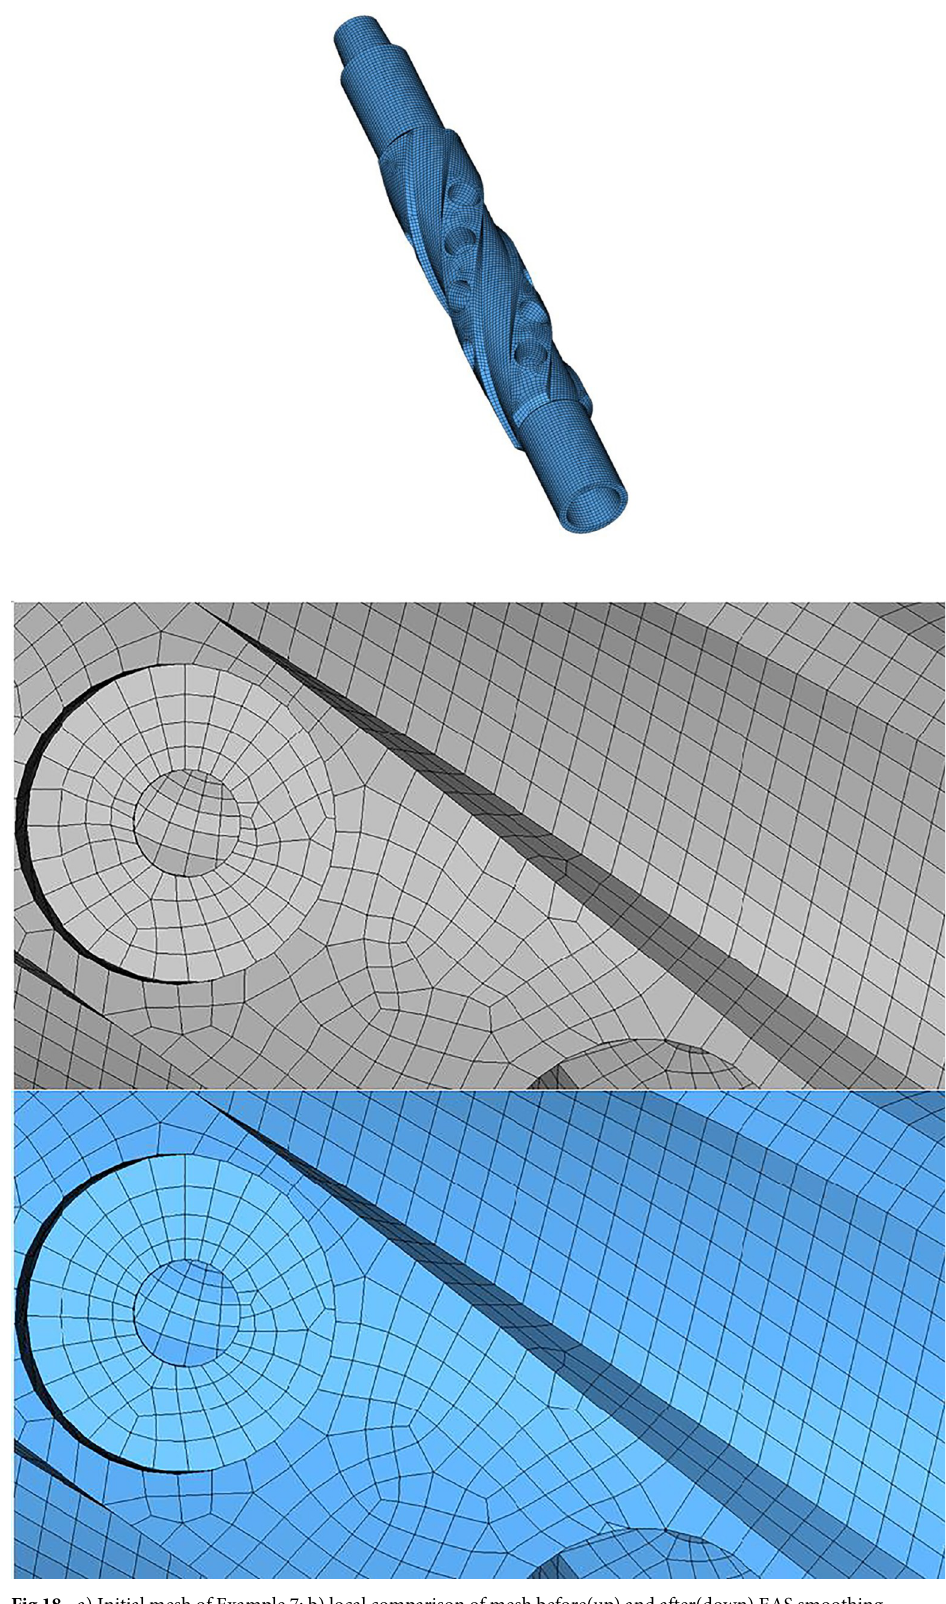
Fig 18. a) Initial mesh of Example 7; b) local comparison of mesh before(up) and after(down) EAS smoothing.